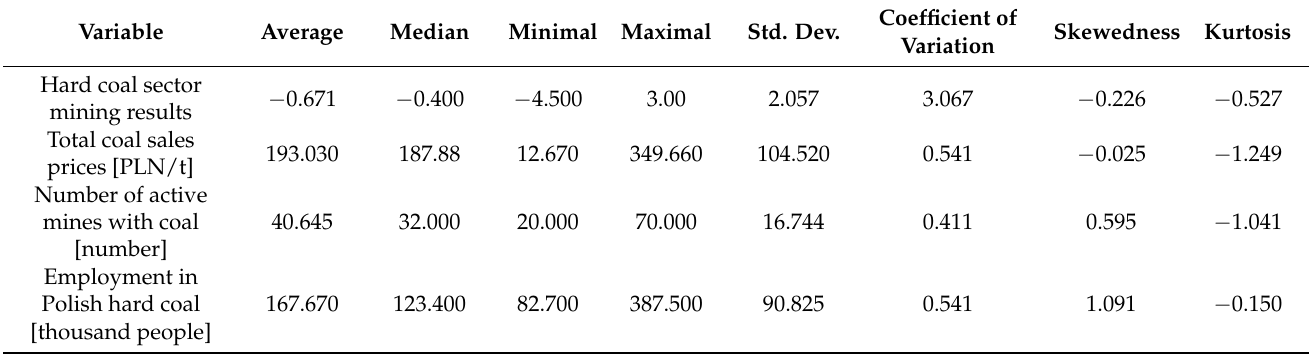
Table 1. Descriptive statistics for total coal sales prices, number of active mines with coal and employment in Polish hard coal in